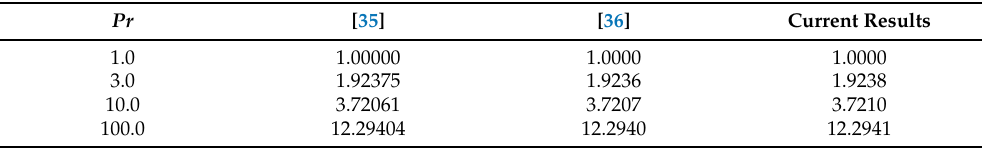
Table 4. The present Nusselt number outcomes validation against M when other involved parameters are not